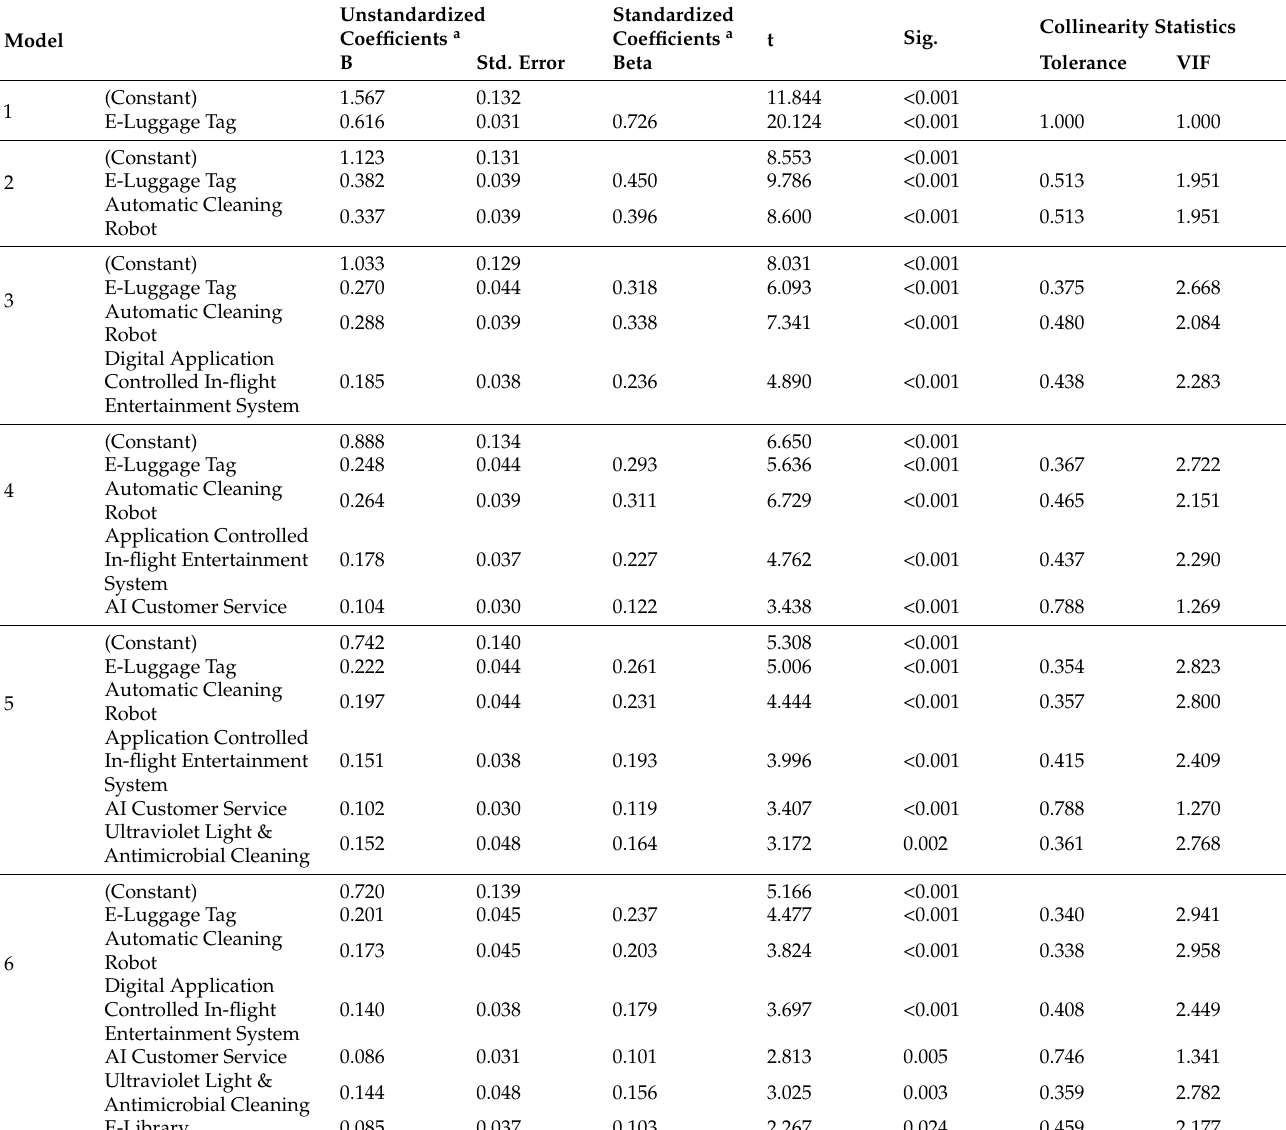
Table A6. Coefficients and collinearity statistics of six regression models generated from stepwise